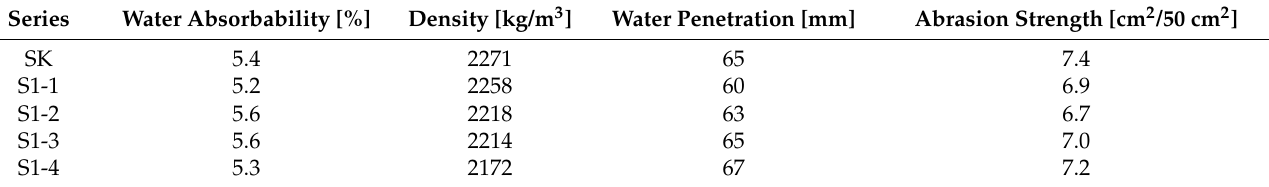
Table 6. Parameters tested for each series of concrete.